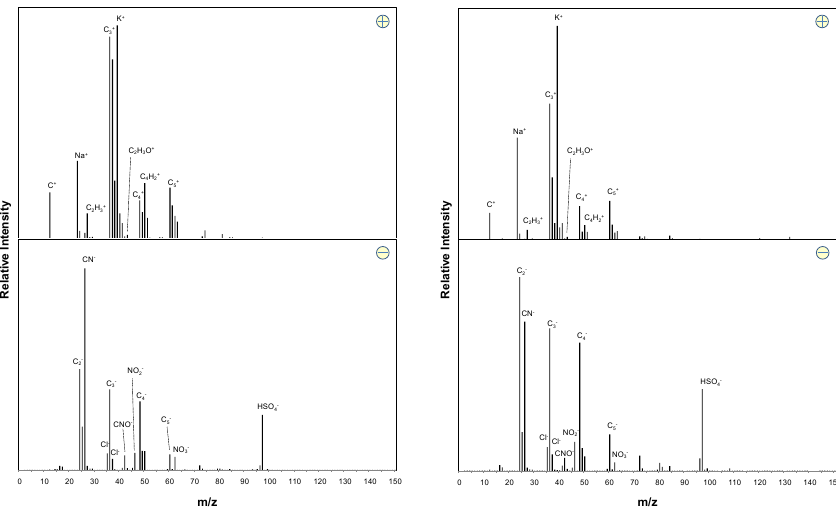
Fig. 3. Average dual ion mass spectra of ambient particles classified as “Peat” (left) and particles sampled during the peat combustion experiment (right).